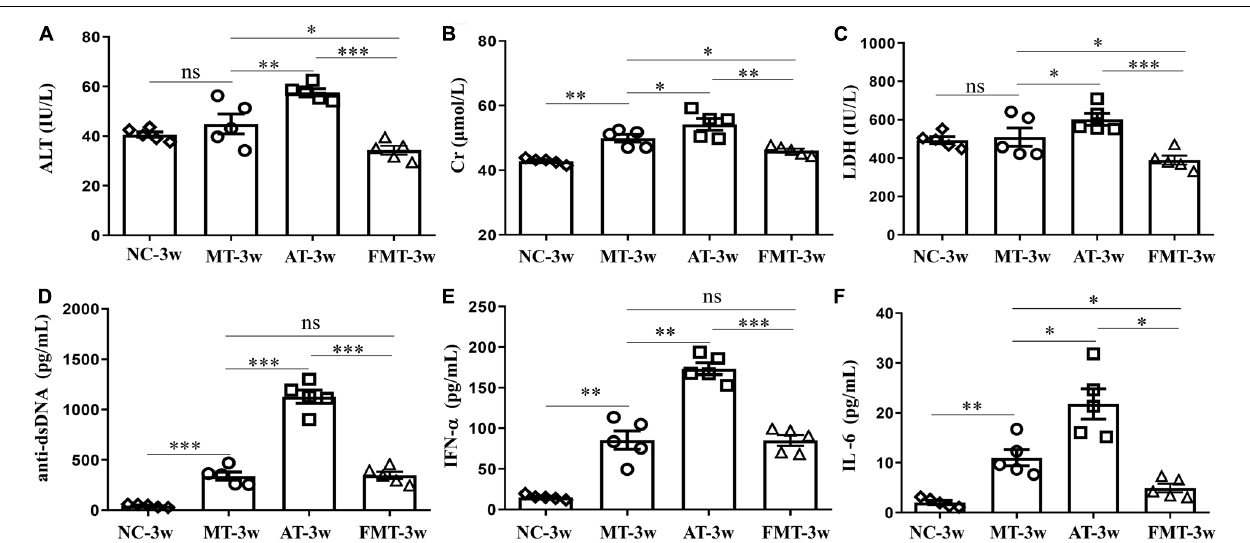
FIGURE 2 | Serum levels of alanine aminotransferase activity (A) , creatinine (B) , lactate dehydrogenase activity (C) , anti-double stranded DNA antibody (D) , interferon- α (E) and interleukin-6 (F) in MRL/lpr mice from the three groups. NC, The C57/BL6 mice treated with PBS solution from 6 to 9 weeks old; MT, the MRL/lpr mice treated with PBS solution from 6 to 9 weeks old; AT, the MRL/lpr mice treated with antibiotics from 6 to 8 weeks old and PBS solution from 8 to 9 weeks old; FMT: the MRL/lpr mice treated with antibiotics from 6 to 8 weeks old and fecal microbiota transplantation from 8 to 9 weeks old. “ ∗∗∗ ”represents p < 0.001; “ ∗∗ ” represents p < 0.01; “ ∗ ” represents p < 0.05; “ns” represents no significant difference. Green arrows indicate the glomerulus. N =